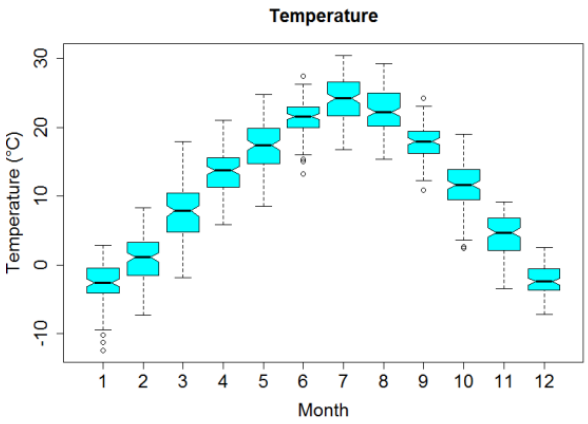
Figure 2. Box plots of monthly averages of temperature in Lanzhou, China, during 2014–2017.